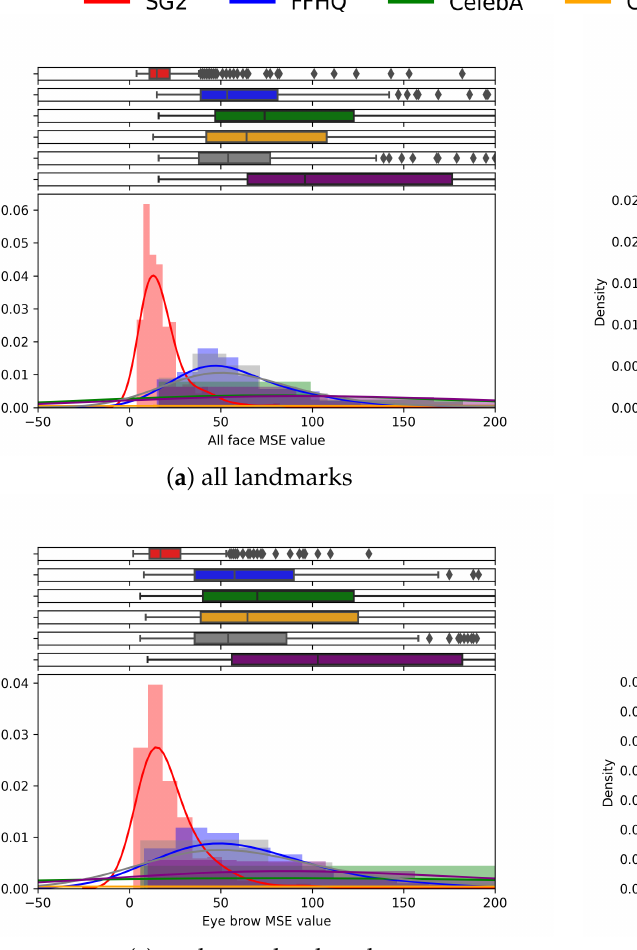
Figure 8. Comparison between FaceNet128 and FaceNet512 features using the MSE. FaceNet512 shows better results: the SG2 faces are well separated with respect to the other datasets, where the distributions tend to overlap each other. FaceNet128 shows an overlap between SG2 and LFW.